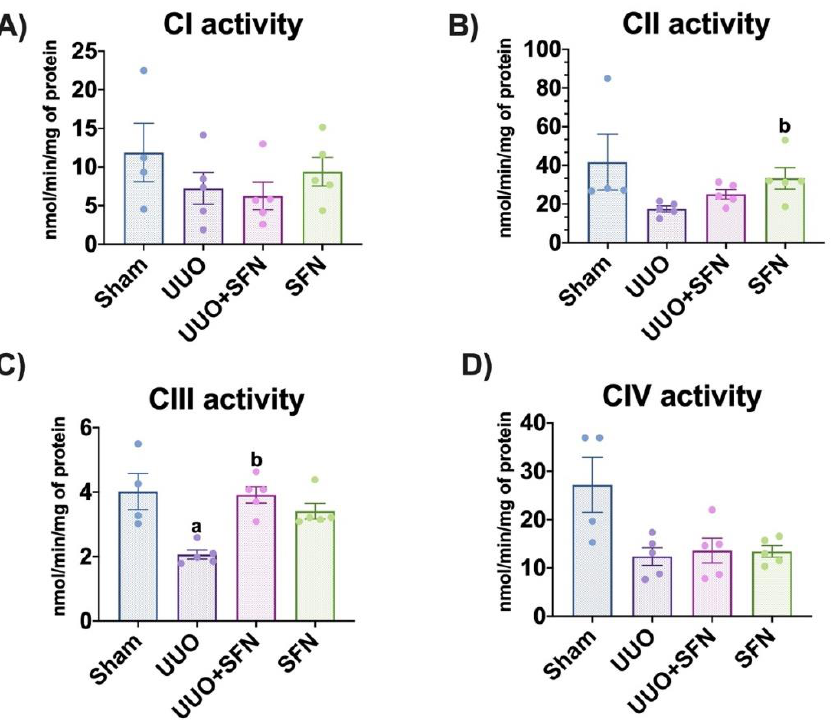
Figure 5. Effect of sulforaphane (SFN) on the enzymatic activities of the electron transport system (ETS) complexes in the unilateral ureteral obstruction (UUO) model. ( A ) Complex I (CI), ( B ) complex II (CII), ( C ) complex III (CIII), and ( D ) complex IV (CIV) were determined in the total renal cortex. Data are mean ± SEM, n = 4 for sham group and n = 5 for UUO, UUO + SFN, and SFN groups. Data were analyzed using a one-way ANOVA and statistical differences were determined with multiple comparisons using Tukey’s test. a p < 0.05 vs. Sham, b p < 0.05 vs. UUO. Sham: simulated surgery without ligation of the ureter; UUO: unilateral ureteral obstruction with double ligation of the left ureter for seven days; UUO + SFN: UUO treated with SFN (1 mg/kg, intraperitoneal) and SFN administered with SFN (1 mg/kg, intraperitoneal).